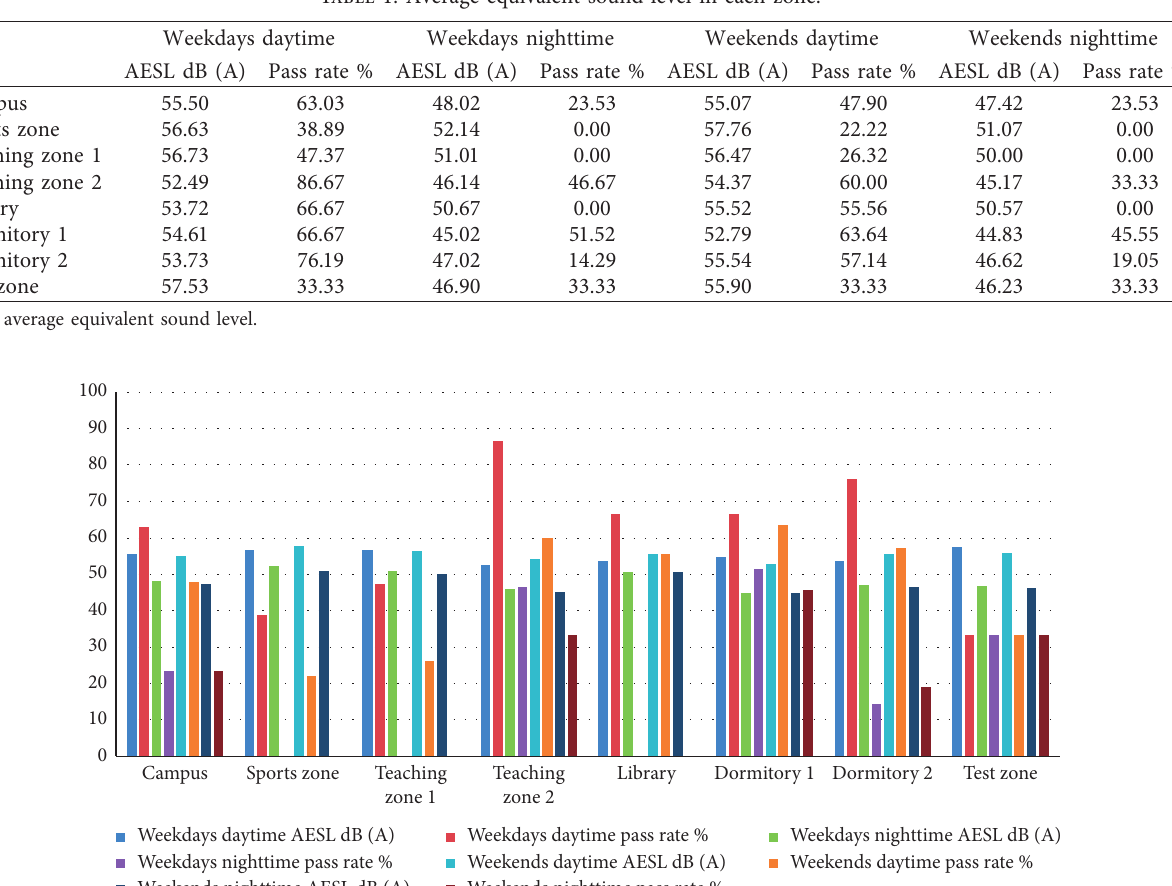
Table 1: Average equivalent sound level in each zone.